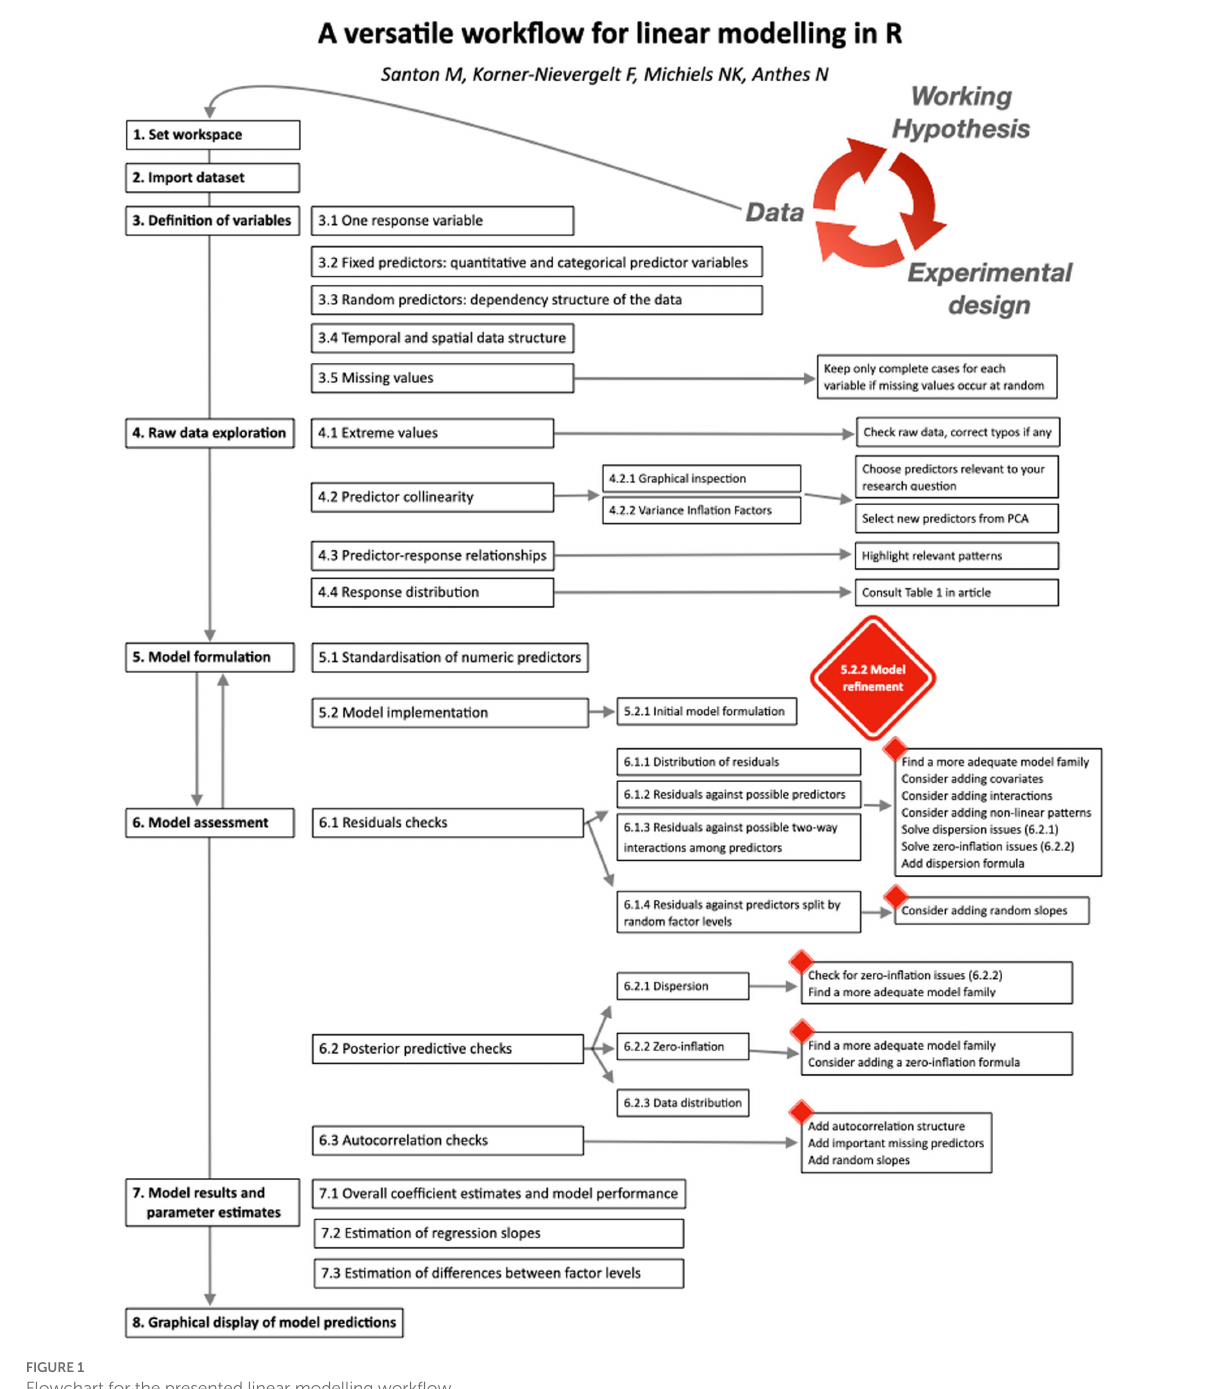
FIGURE 1 Flowchart for the presented linear modelling